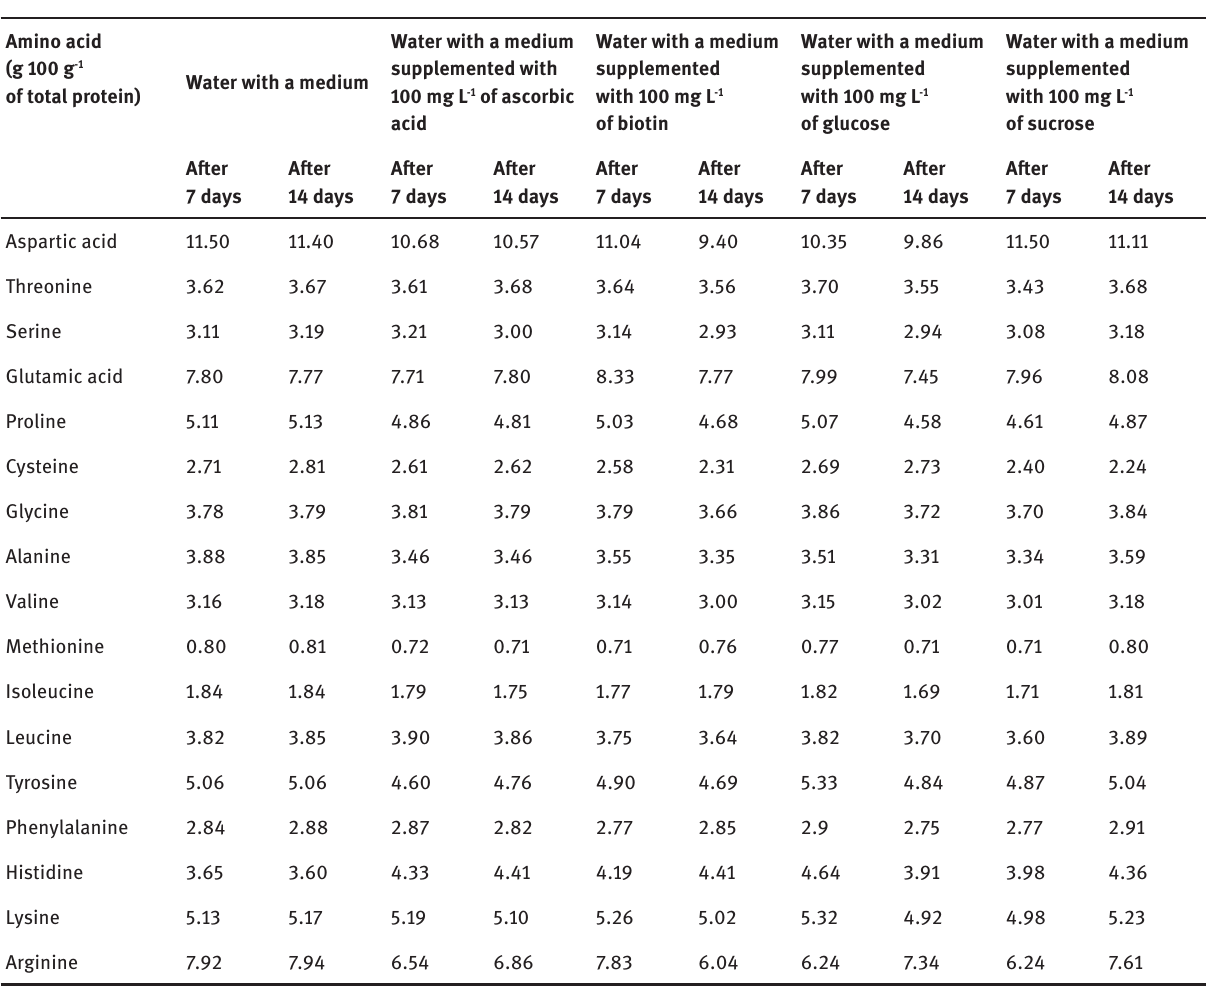
Table 2: Amino acids content [g 100 g -1 of total protein] in biomass of cultured Aegagropila linnaei